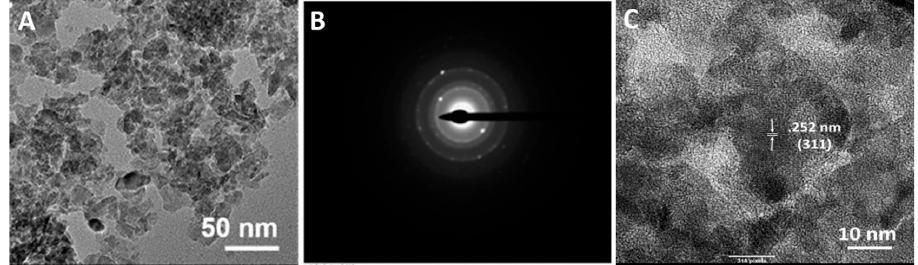
Figure 1. ( A ) Transmission electron microscope (TEM) image of Magnesium ferrite (Mg-ferrite) nanoparticles at lower magnification; ( B ) Corresponding selected area diffraction pattern; and ( C ) TEM image of Mg-ferrite nanoparticles at higher magnification.